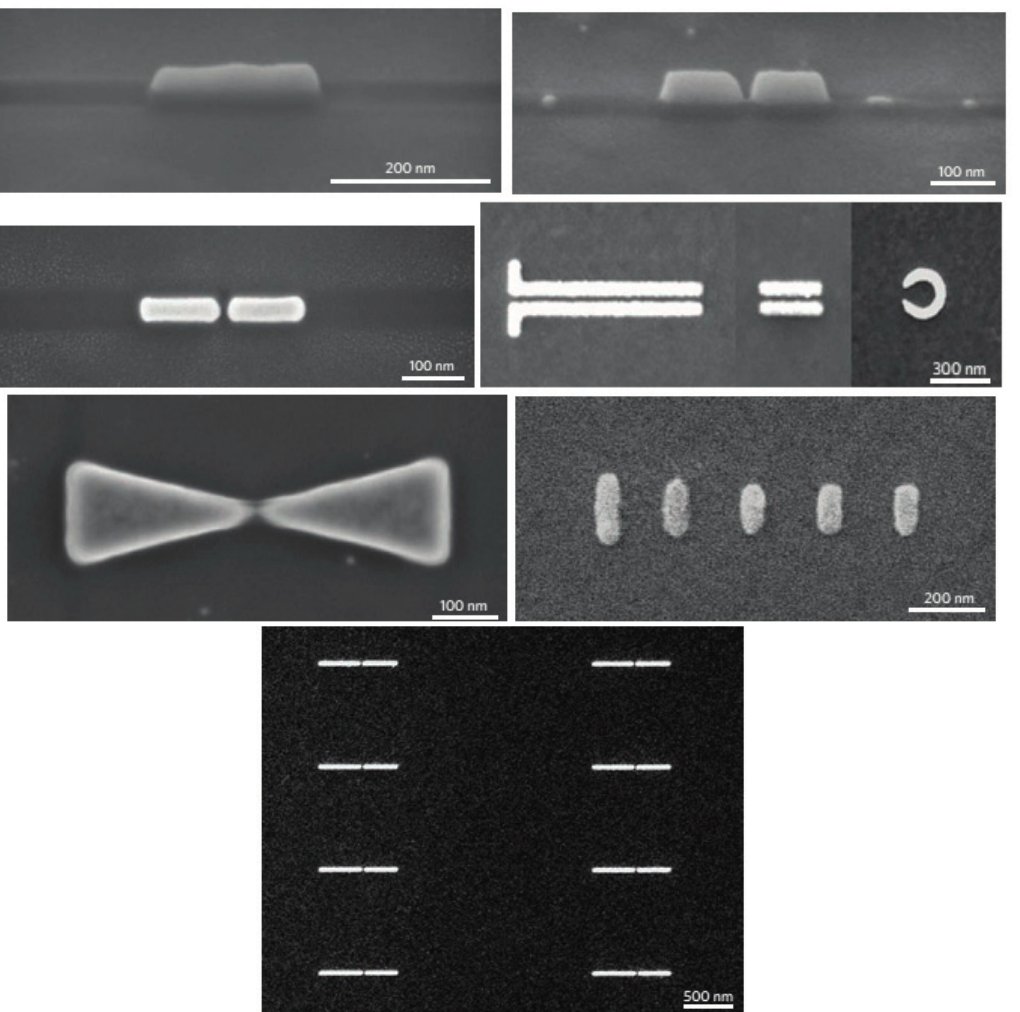
Figure 1. Optical antennas of different